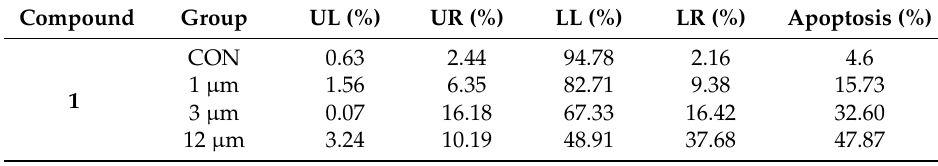
Table 3. Effect of compound 1 on the apoptosis rate of HepG2 cells.